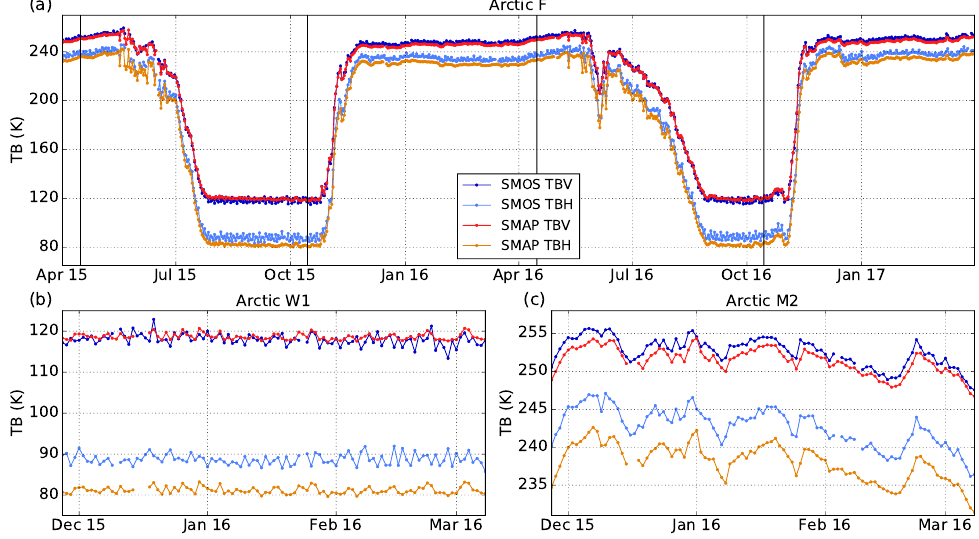
Figure 9. Timeseries of polarized brightness temperatures in the Arctic averaged over the boxes with ( a ) first-year ice (box F in Figure 7a); ( b ) water (box W1); and ( c ) multi-year ice (box M2). The vertical lines mark the start and end times of the freeze-up period (15 October-15 April) considered for the ice thickness retrieval.